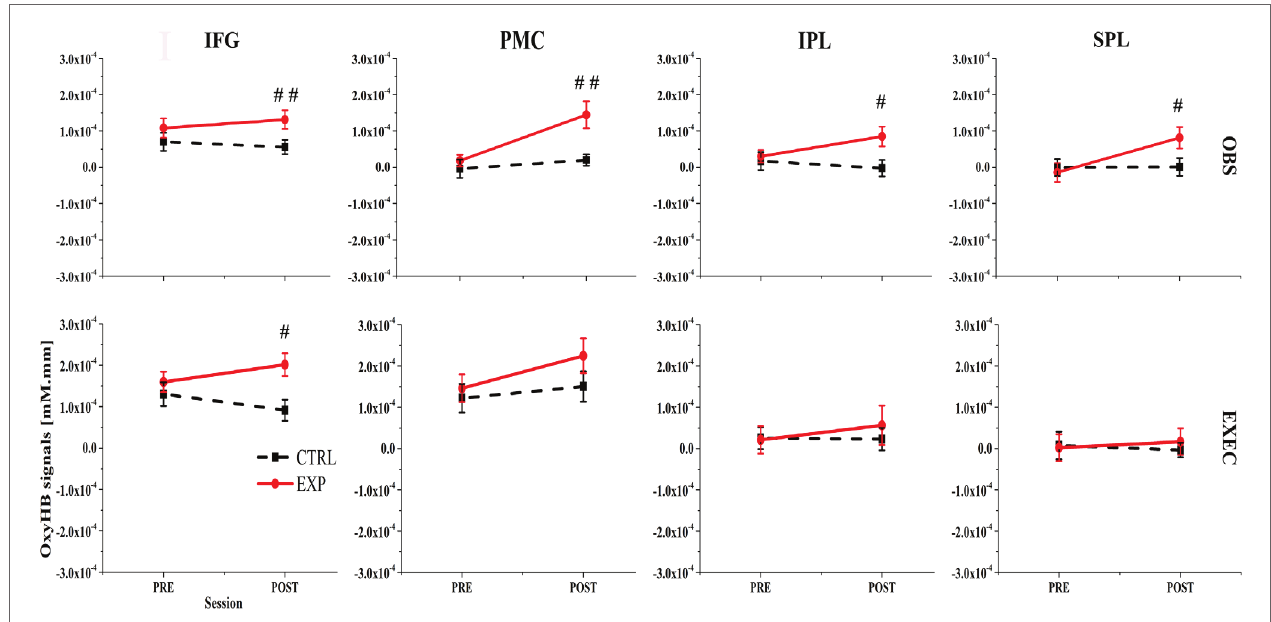
FIGURE 3 | First row lists the action observation (OBS) component and the second row lists the action execution (EXEC) component. IFG, inferior frontal gyrus; PMC, premotor cortex; SPL, superior parietal lobule; IPL, inferior parietal lobule; # represents a significant difference between pre-ctrl and pre-exp condition or post- ctrl and post-exp condition, # p < 0.05; ## p < 0.01; ### p <